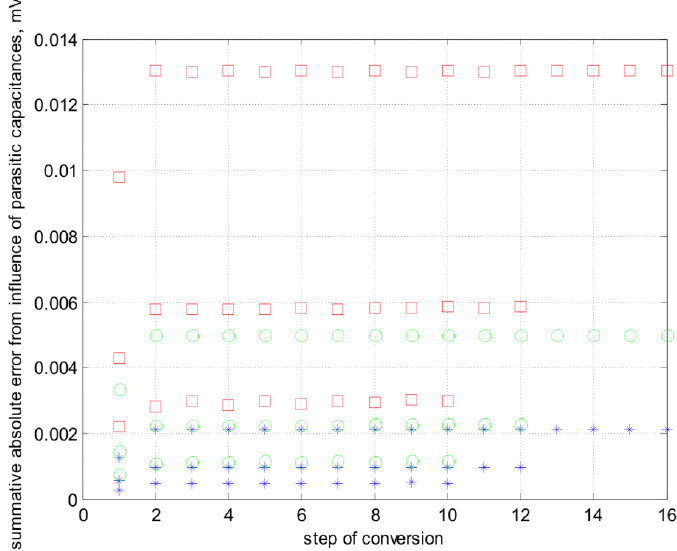
Figure 6. The absolute summative error ∆ U ms , caused by the influence of parasitic capacitances of components of the LADC with successive approximation on SC with a variable logarithm base ( C 1 = C 2 = 1 nF). LADC bits: 16—square, 12—circle, 10—star; C p : 4 pF—red, 2 pF—green, 1 pF—blue.